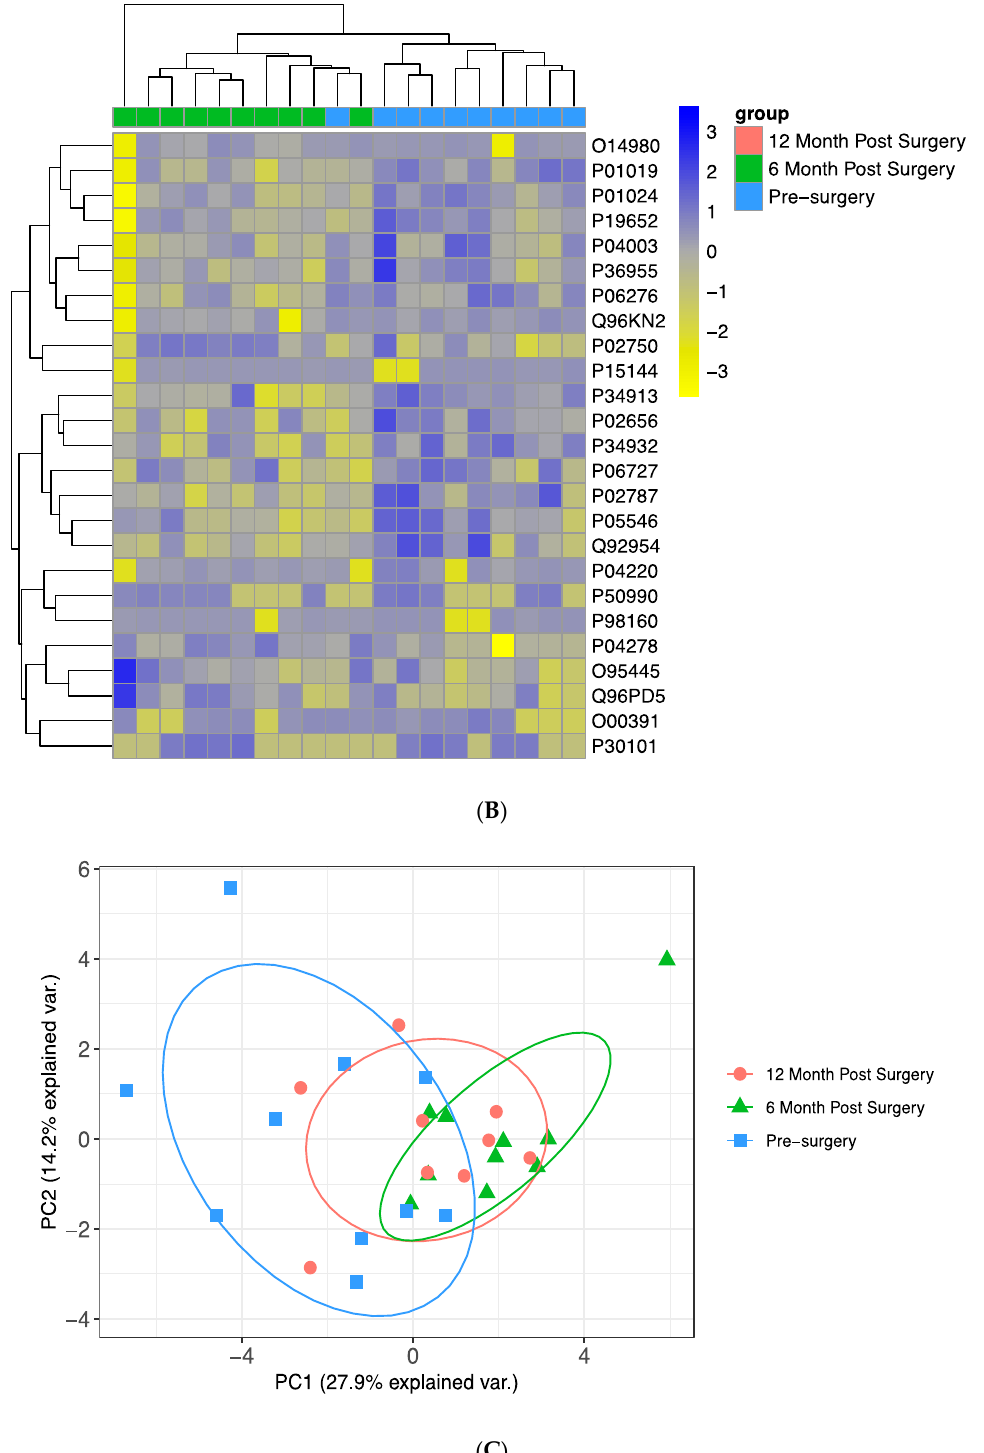
Figure 2. Protein abundance changes 6 months post-surgery. ( A ) Volcano plot: green points are significant and have a fold change > 1, red points are significant but have a fold change < 1 and black points are not significant. ( B ) Hierarchical clustering and heatmap of all 25 proteins significantly different 6 months post-surgery relative to pre-surgery samples. Hierarchical clustering was performed using the Euclidean distance. Row scaling was performed on the log2 abundance for each protein by the subtraction of the mean from each feature and then dividing by the standard deviation. ( C ) Principal component analysis with all 25 proteins significantly different 6 months post-surgery relative to pre-surgery